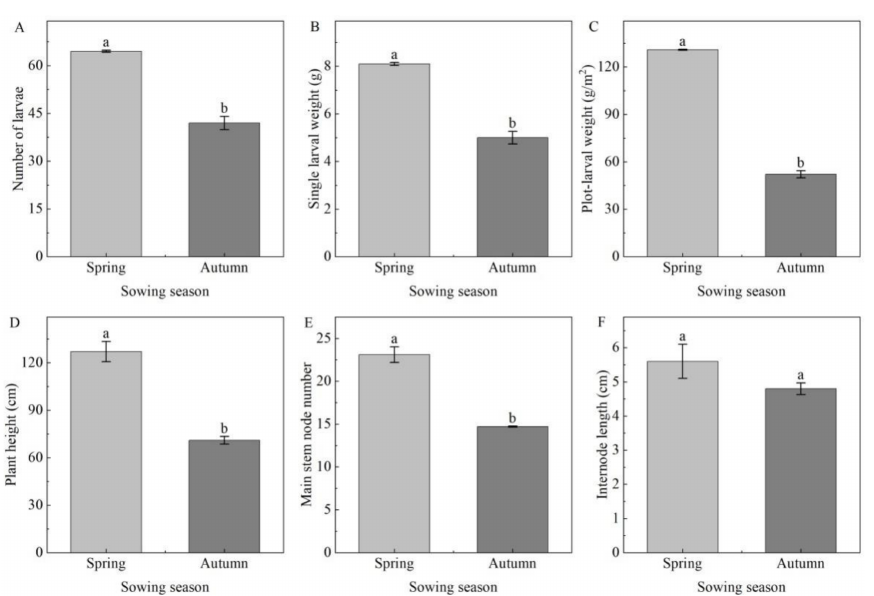
Figure 5. Comparison of growth indicators of C. bilineata tsingtauica larvae and soybean plants between spring and autumn sowing: ( A ) number of larvae; ( B ) single larval weight; ( C ) plot-larval weight; ( D ) plant height; ( E ) main stem node number; ( F ) internode length. Different lowercase letters between spring and autumn sowing indicate significant differences of p <